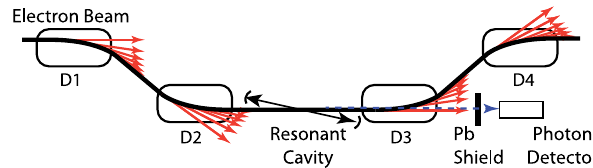
FIG. 1. Hall A Compton polarimeter. Fan-shaped regions qualitatively represent synchrotron radiation.